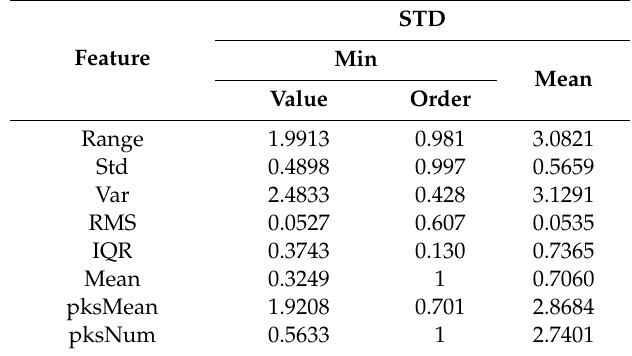
Table 3. Mean and min of standard deviation of each feature of upstairs.